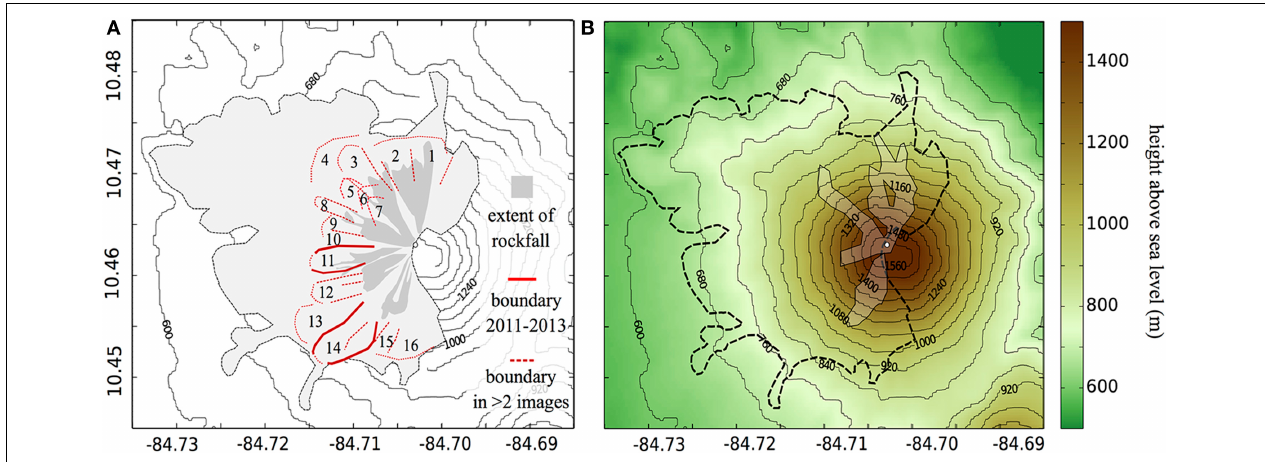
FIGURE 5 | (A) An interpretative map constructed from examination of 10 interferograms with a high signal to noise ratio is shown in (A) . The pale gray outline shows the region of SAR coherence, while the darker gray shows the area of persistent rockfalls. Solid red lines indicate the position of units